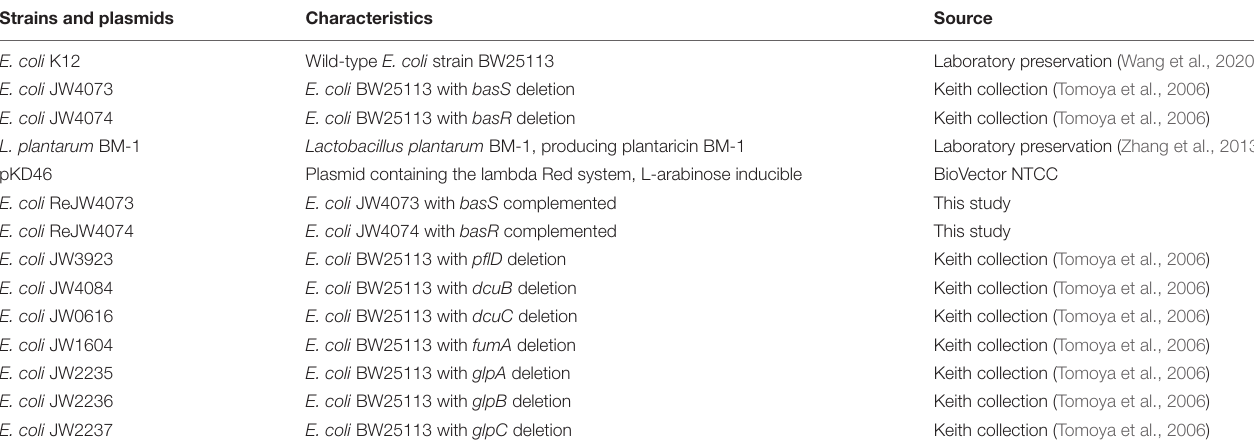
TABLE 1 | Strains used for the study.